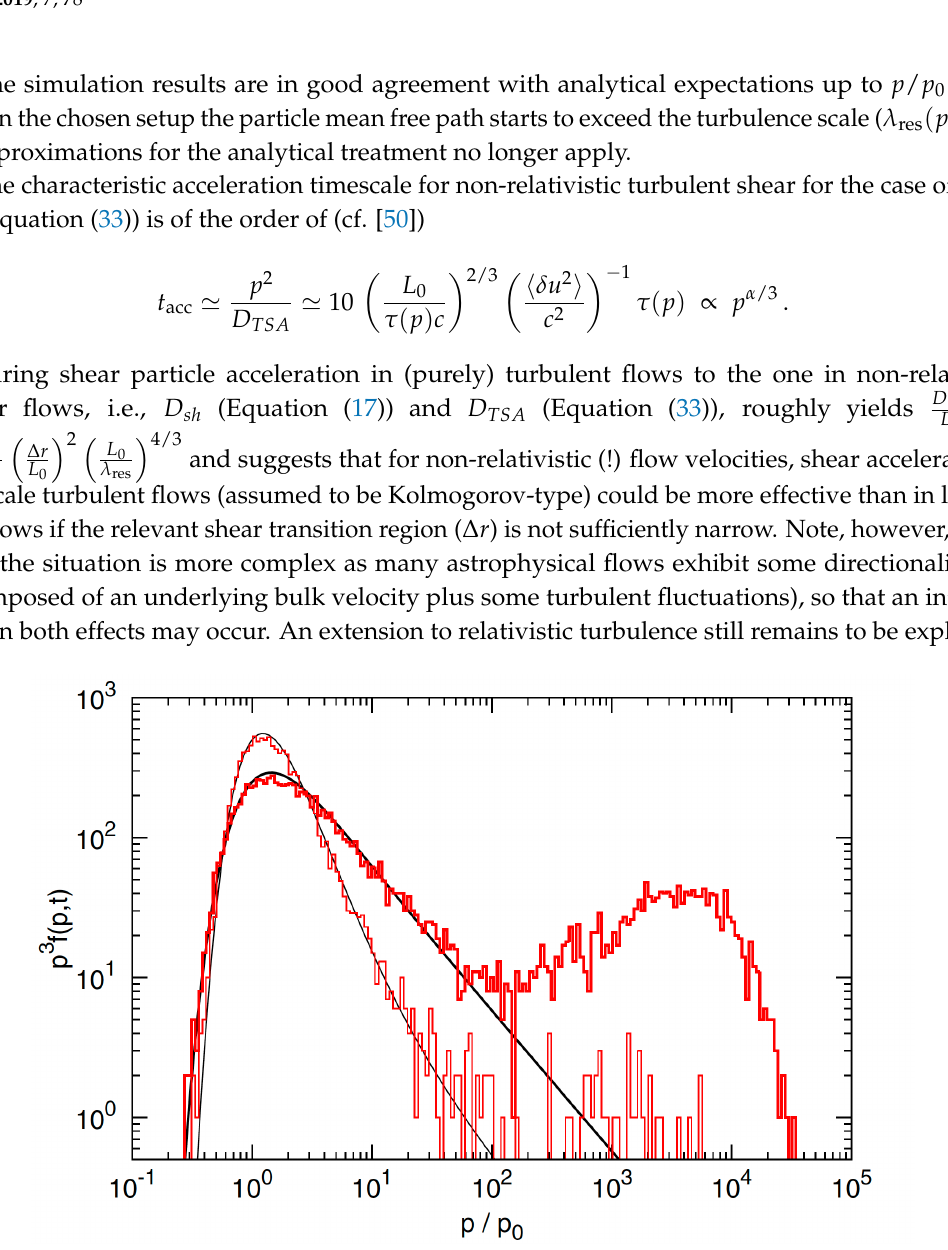
Figure 10. Particle distribution function for turbulent shear acceleration at two different times assuming static incompressible velocity turbulence with mean amplitude (cid:104) δ u 2 (cid:105) = ( 0.05 c ) 2 . Red histograms show results of Monte Carlo simulations for a mono-chromatic wave spectrum S ( k ) ∝ δ ( k − k 0 ) with τ 0 ck 0 = 0.01, where τ ( p ) = τ 0 ( p / p 0 ) (i.e., α = 1) has been employed. Thin and thick lines show analytical solutions at times t / τ 0 = 5 × 10 6 and 10 7 , respectively. The formation of a power-law tail f ( p ) ∝ p − 4 above injection p 0 and below p / p 0 ∼ 10 2 becomes apparent with time. Deviations with regard to the analytical solutions are seen towards higher momenta ( p / p 0 > 10 2 ) where the particle mean free path λ res starts exceeding the turbulence scale L 0 = 2 π / k 0 . From Ref.